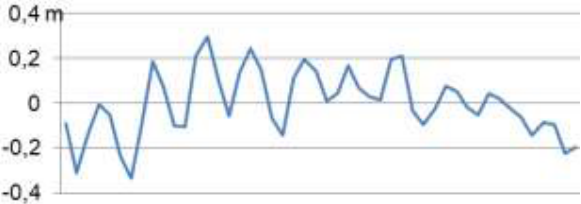
Figure 17. Averaged Cartosat-1 y-parallax over 34 km in